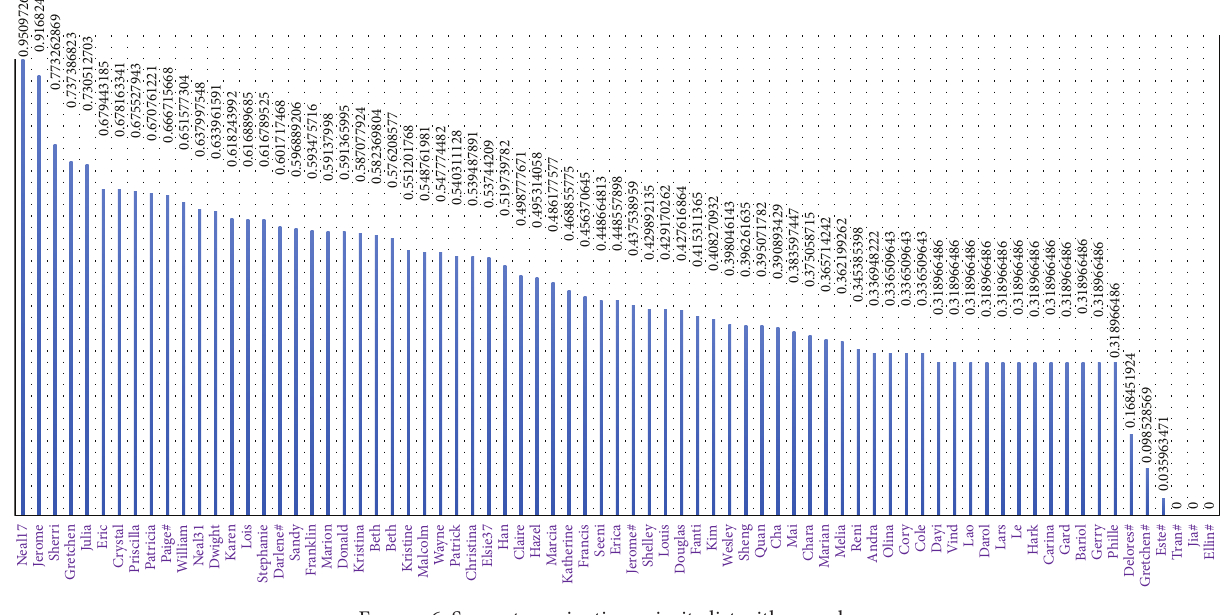
Figure 6: Suspect nomination priority list with new clues.